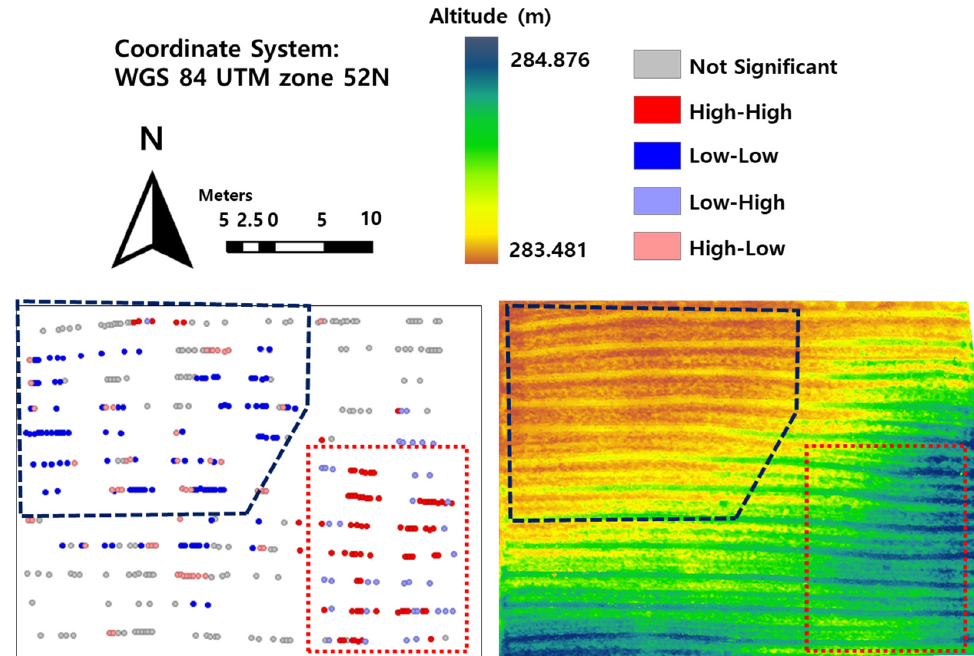
Figure 2. The comparison of cluster patterns in the LISA map and terrain elevation patterns of the altitude map in the breeding field. The blue dotted polygon in the LISA map and the terrain elevation map is representative of the low-growth region and the low-altitude region, respectively. The red dotted polygon in the LISA map and the terrain elevation map is representative of the high-growth region and the high-altitude region, respectively.